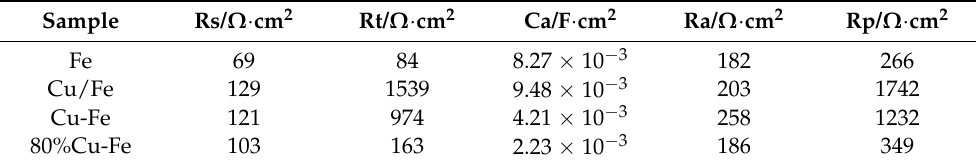
Figure 7. EIS plots and fitting results of different materials in 3.5% NaCl solution ( a ) Fel, ( b ) 80%Cu-Fe ( c ) Cu/Fe ( d )Cu-Fe. Table 3. Fitting result of EIS for carbon steel and Cu-Fe alloy in 3.5% NaCl